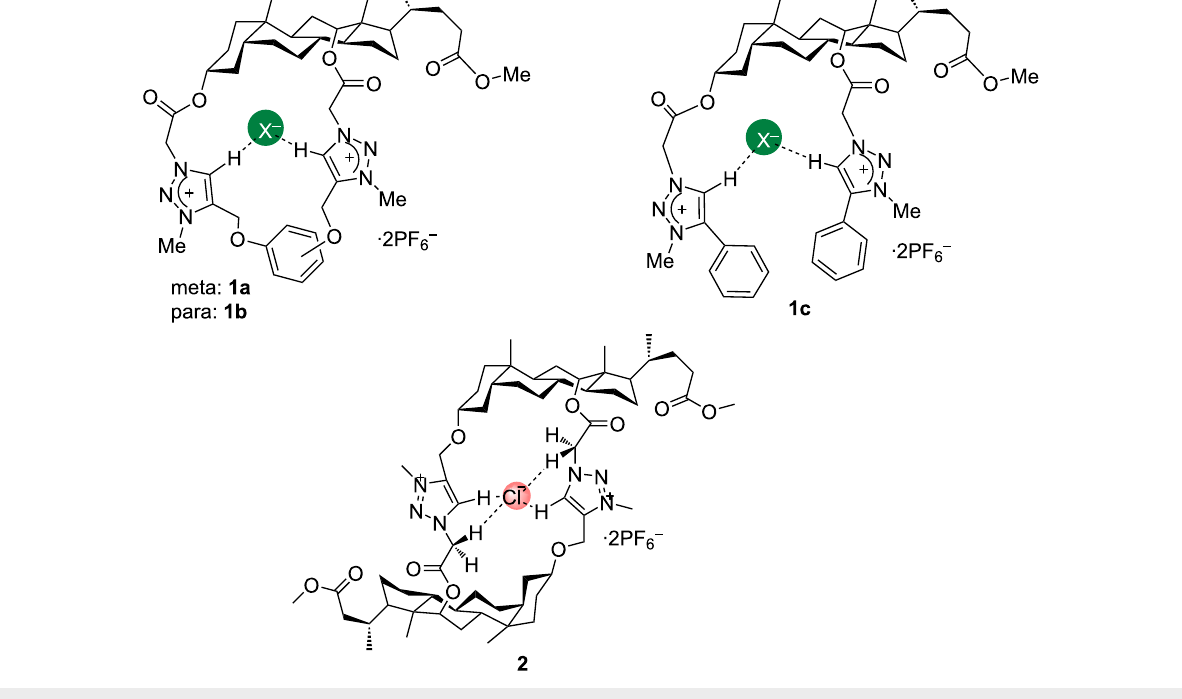
Figure 3: Chemical structure of compound 1 ( 1a , 1b and 1c ) and 2 .